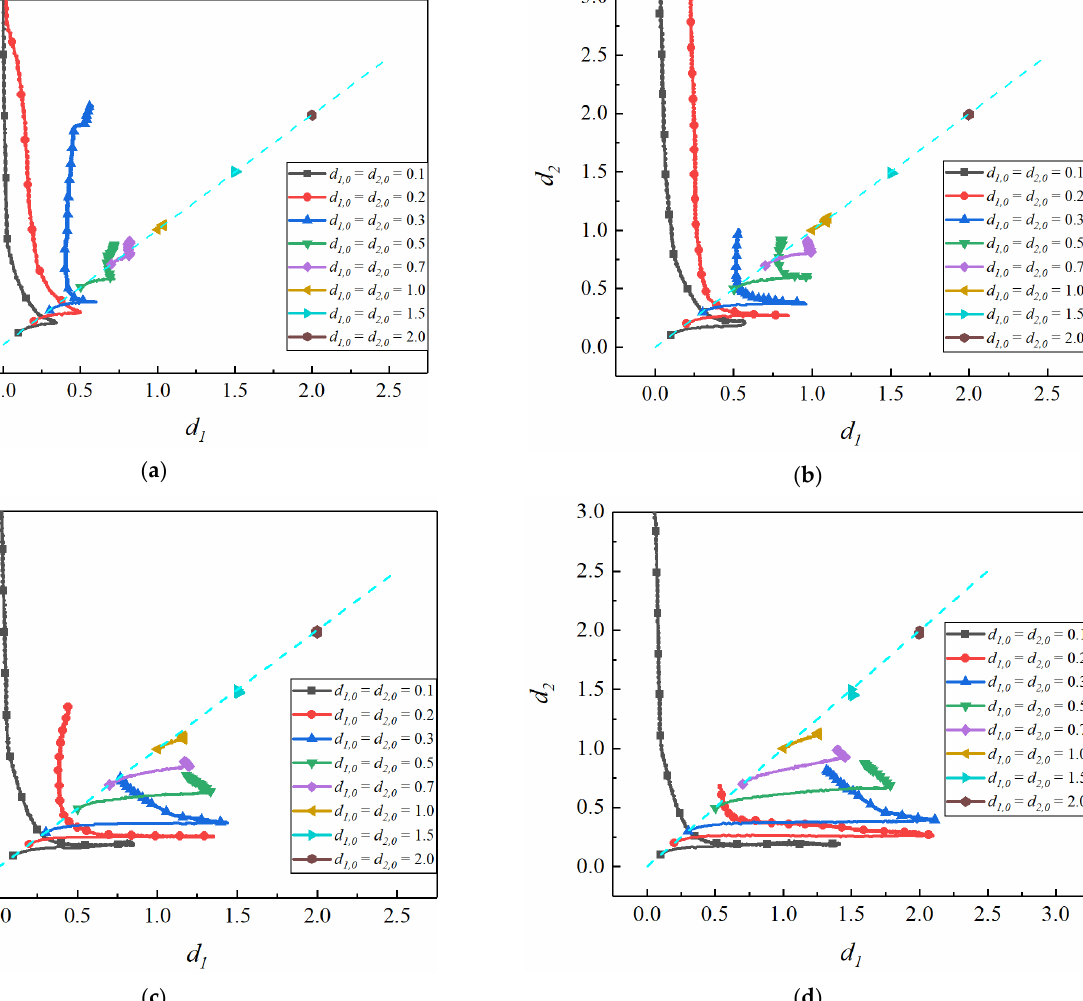
Figure 9. Diverse variations of interparticle distances for different initial interparticle distances and α ( Wi = 0.5, η r = 0.3, ε = 0.3, y 0 = 0.1). ( a ) α = 0.1; ( b ) α = 0.3; ( c ) α = 0.5; ( d ) α = 0.7.